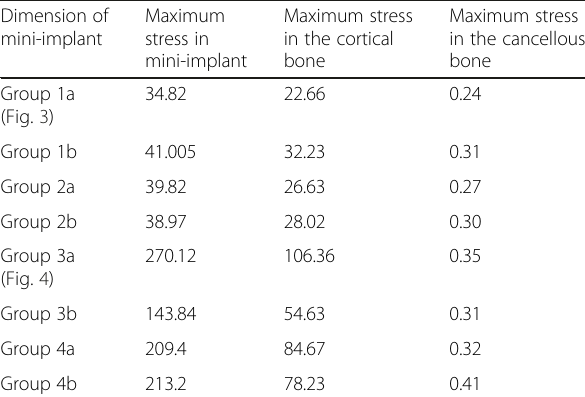
Table 3 Maximum von Mises stress (MPa) for force simulating anterior retraction Dimension of